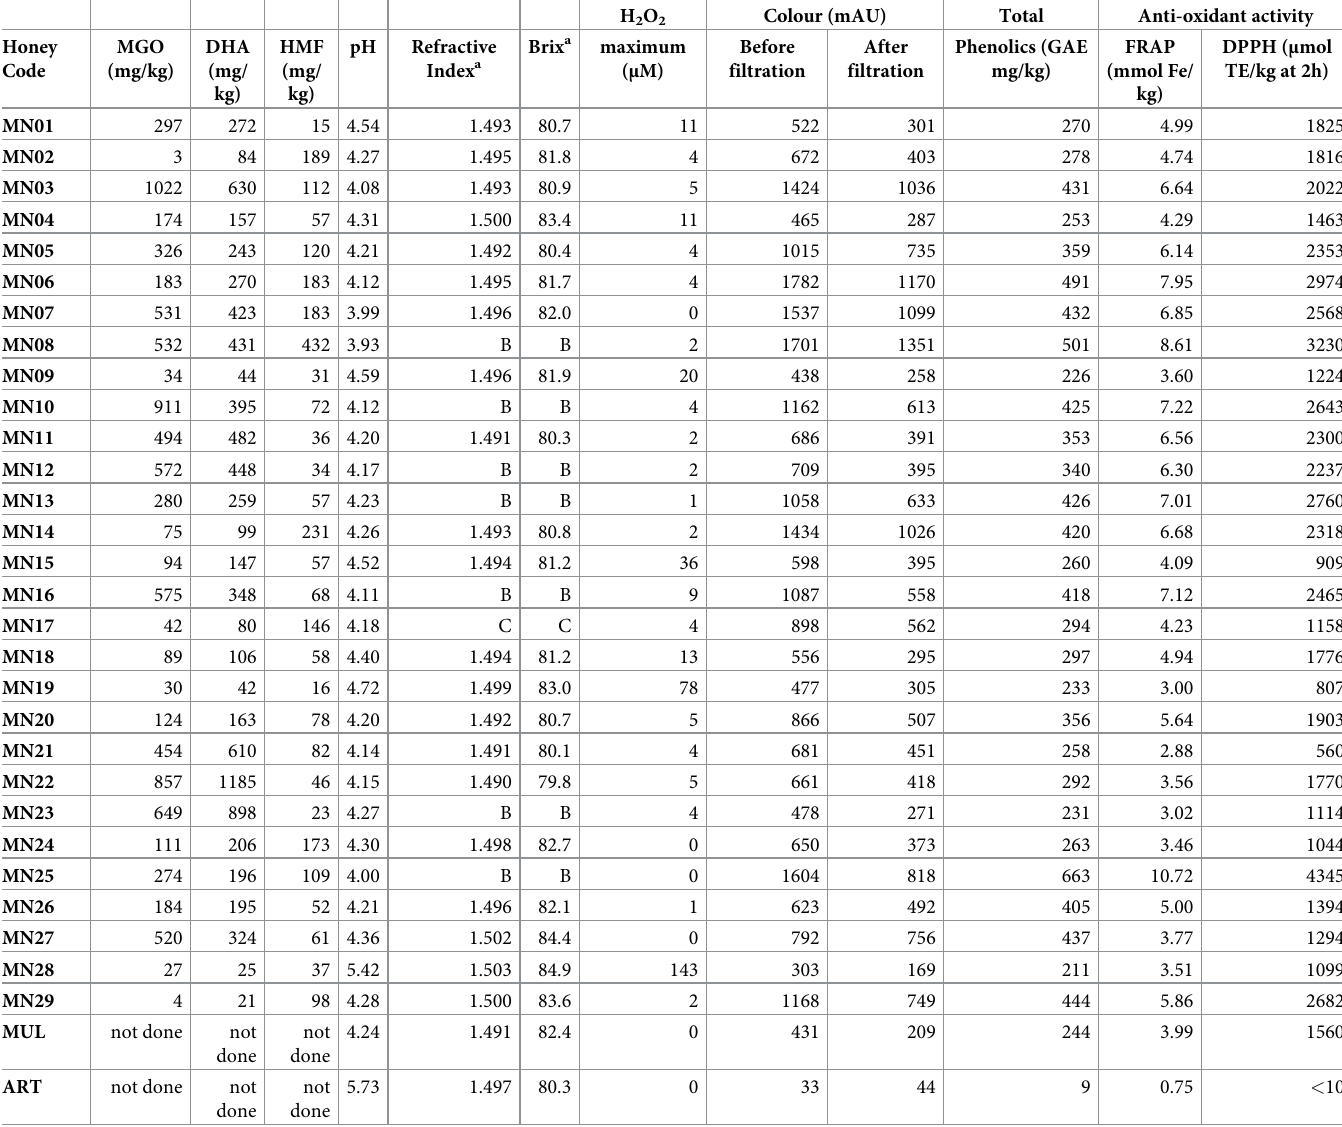
Table 2. Physicochemical properties, MGO, DHA and HMF content, and antioxidant activity of manuka/ Leptospermum and comparator